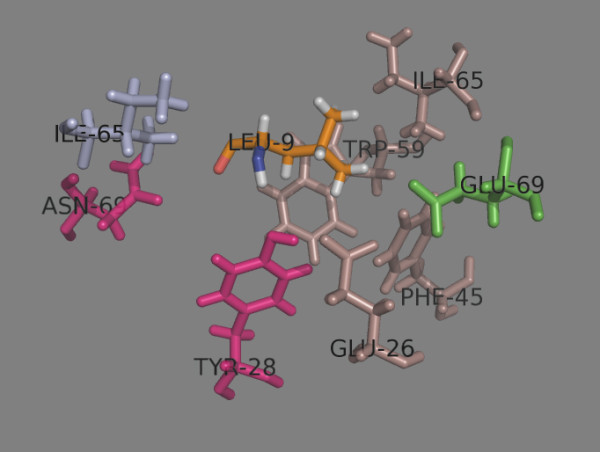
Peptide position 7. The α chain residues are shown in light blue, the β chain residues – in darksalmon The dimorphic Glu/Lys69β is shown in green. Asn69α and Tyr28β (given in magenta) make H-bonds with p7 residue Leu (given as LEU-9 in orange).